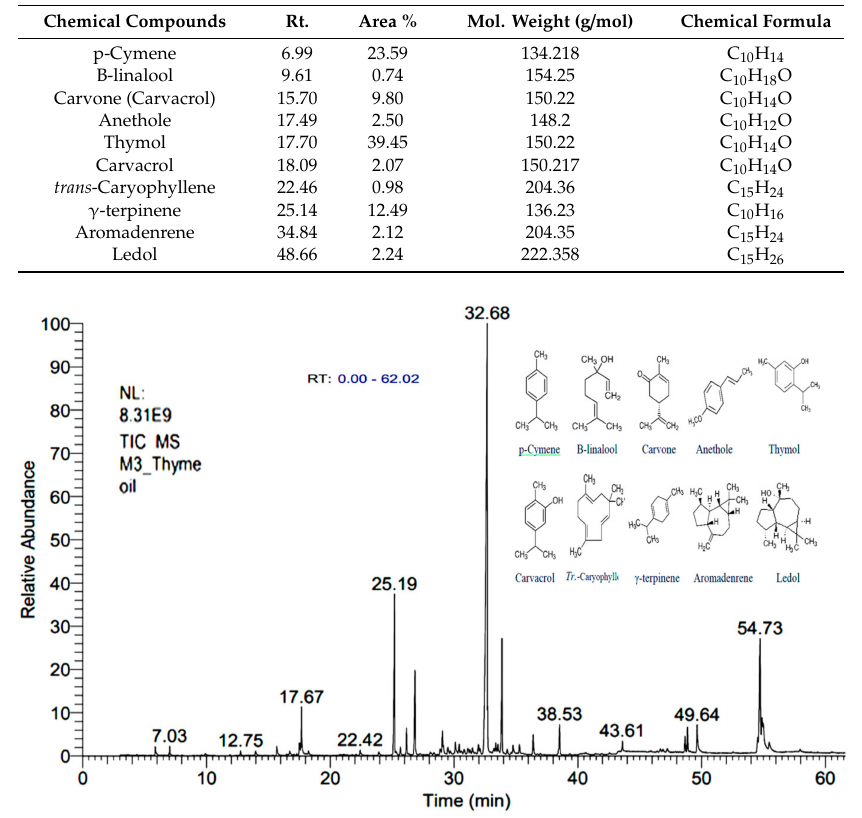
Table 2. Major chemical compounds of hydrodistilled thyme essential oil (THO) as detected by gas chromatography spectrophotometer (GC-MS).